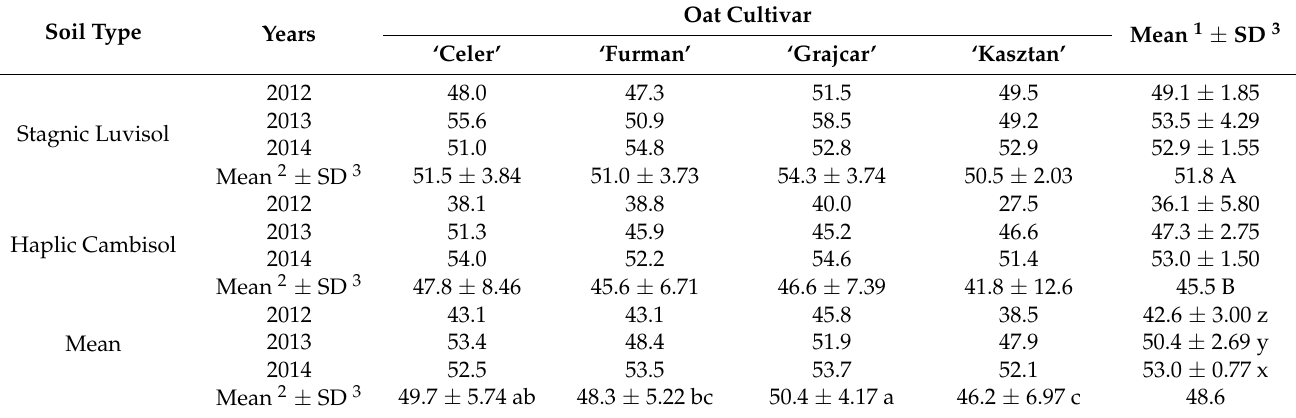
Table 14. 1000-seed mass (g) of vetch cv. ‘Hanka’ of the mixture depending on the soil type (factor I), oat cultivar (factor II), and study years (factor